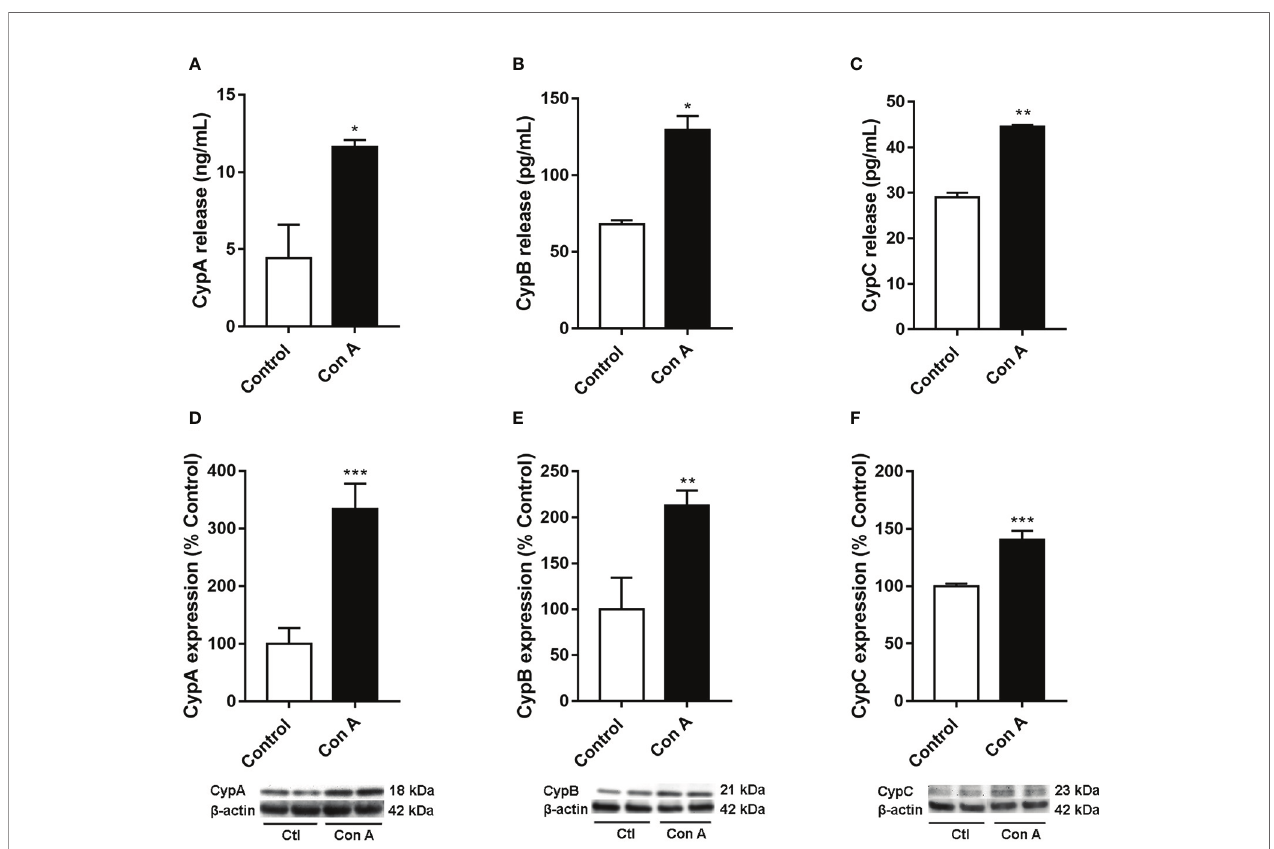
FIGURE 2 | Intra and extracellular CypA, B, and C levels in human T lymphocytes stimulated with Con A Cells were treated with Con A (50 m g/mL) for 48 h. CypA (A) , CypB (B) , and CypC (C) levels were measured by ELISA in the medium of T lymphocytes. The intracellular expression of CypA (D) , CypB (E) , and CypC (F) was measured by western blot in cytosolic lysates of T lymphocytes. Band intensity was normalized by b -actin. Data are the result of average ± SEM (n = 3). The values are shown as the difference between cells treated with Con A and untreated cells, * p < 0.05, * p < 0.01 and *** p < 0.001. One-way ANOVA test with Dunnet ’ s post hoc analysis and Student´ s t-test were used for statistical